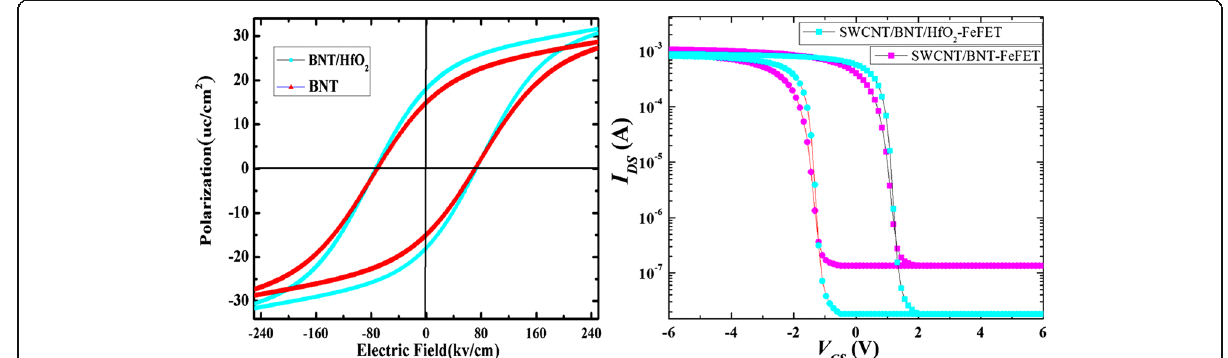
Fig. 8 Simulation of a P - E hysteresis loops of BNT and BNT/HfO 2 films and b I DS - V GS curve for the SWCNT/BNT/HfO 2 -FeFET and